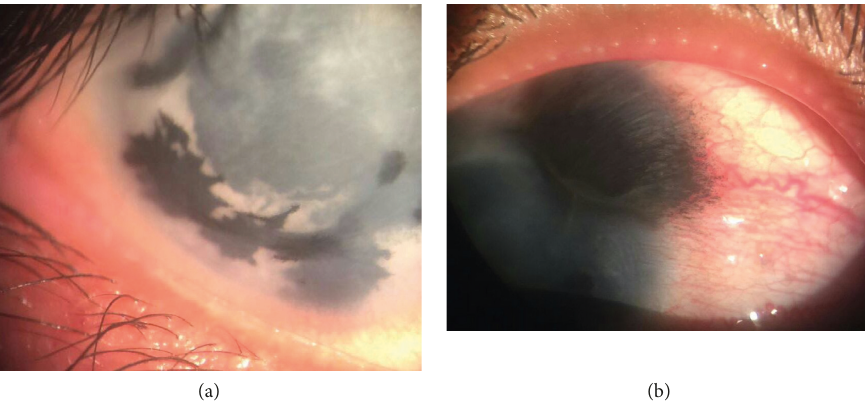
Figure 4: (a) Insufficient corneal staining. (b) Dye seepage into the conjunctiva.